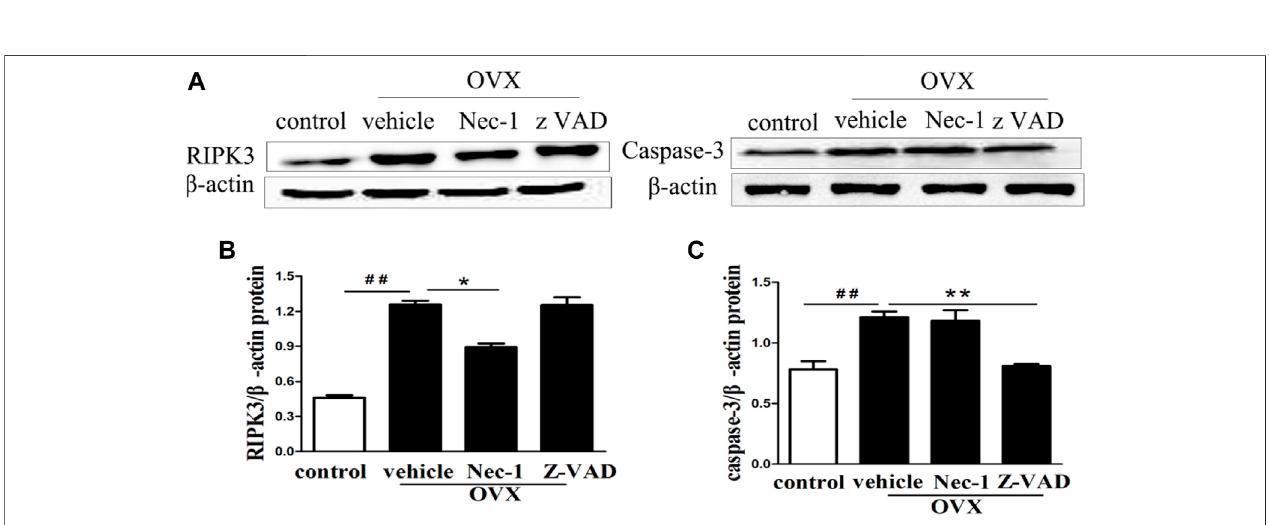
FIGURE4|(A) WesternblotofRIPK3andcaspase-3proteinexpressionintheosteocytesofeachgroup.Thequantitativeanalysesof (B) RIPK3and (C) caspase- 3 protein expression. Nec-1 and zVAD were associated with signi fi cantly reduced expression of RIPK3 and cleaved Caspase-3 (n (cid:1) 6), respectively. ## p < 0.01 compared with control group, * p < 0.05 compared with the vehicle group, ** p < 0.01 compared with vehicle